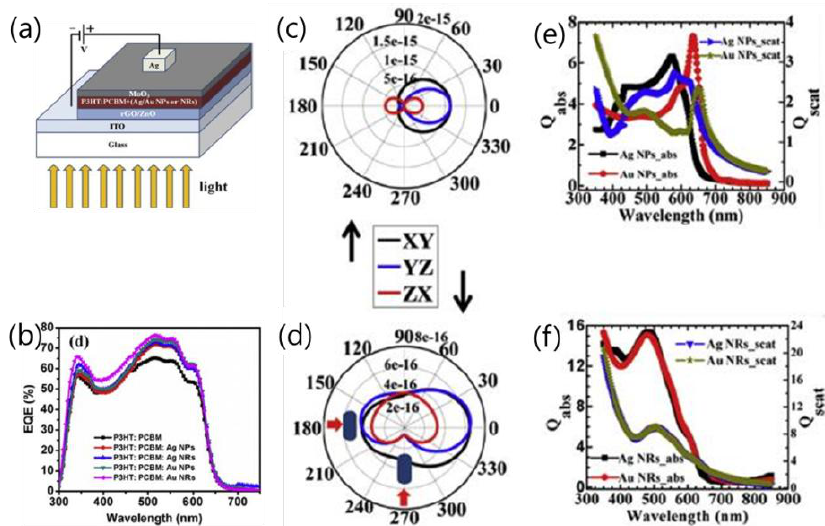
Figure 11. ( a ) Device architecture of ITO/rGO (0.4 wt %) ZnO/P3HT: PCBM: 20 wt % of Ag/Au NPs or NRs; ( b ) EQE spectra of ITO/rGO (0.4 wt %) ZnO/P3HT:PCBM: 20 wt % of Ag/Au NPs or NRs photovoltaic devices (Ag NPs 71%, Ag NRs 73%, 74% for Au NPs and 76% for Au NRs; ( c , d ). The angular distribution of scattered radiation in XY, YZ, and XZ planes. The Absorption (Qabs) and scattering (Qscat) cross sections of ( e ) Ag NPs (or) ( f ) NRs at various wavelengths of the incident spectrum [51]. Reprinted with permission from Ref. [51].